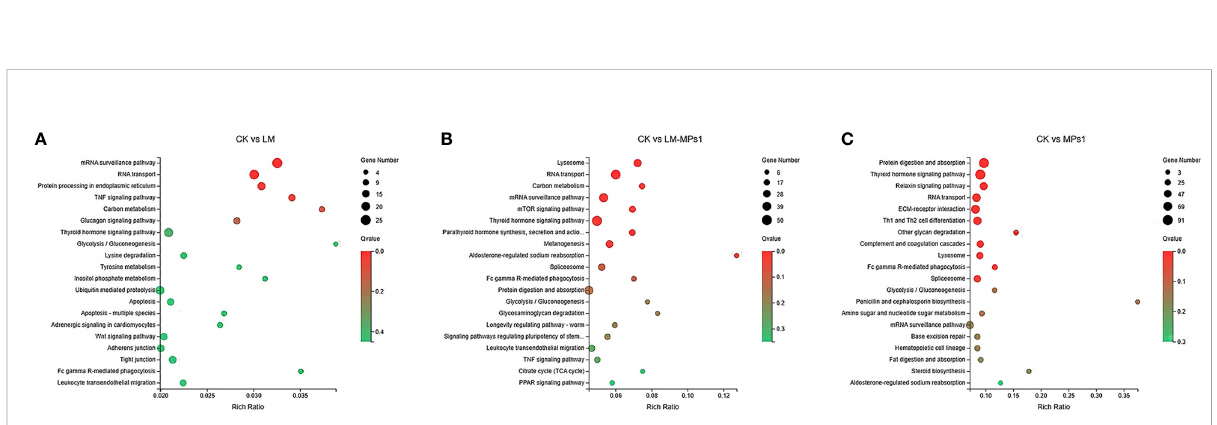
FIGURE 5 Bubble diagram of top 20 KEGG pathways enrichment of DEGs in different pairwise comparisons of the digestive gland. (A) , CK vs. LM; (B) , CK vs. LM_MPs1; (C) , CK vs.